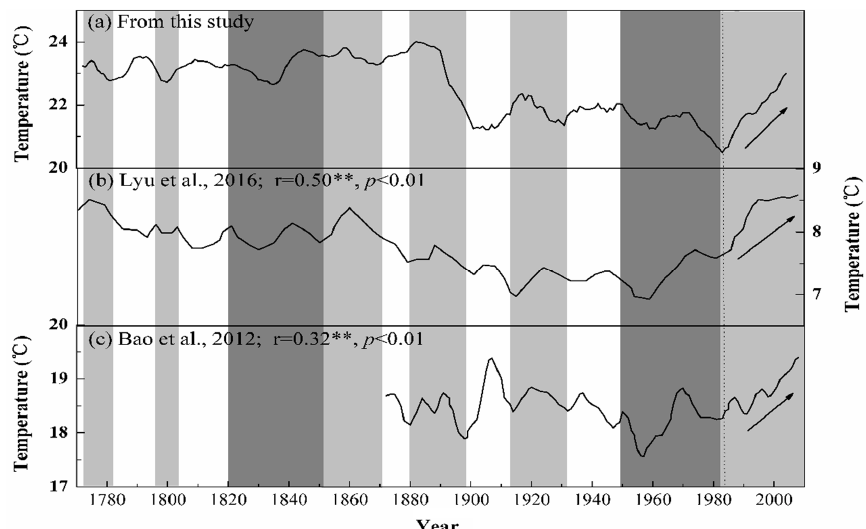
Figure 8. Comparison of June–July maximum temperature (T max6–7 ) reconstruction between ( a ) this study, ( b ) April–July temperature reconstruction by Lyu et al., 2016 [36], and ( c ) April–September temperature reconstruction by Bao et al., 2012 [27]. The light/dark gray shading areas represent the common warm/cold periods in different series.